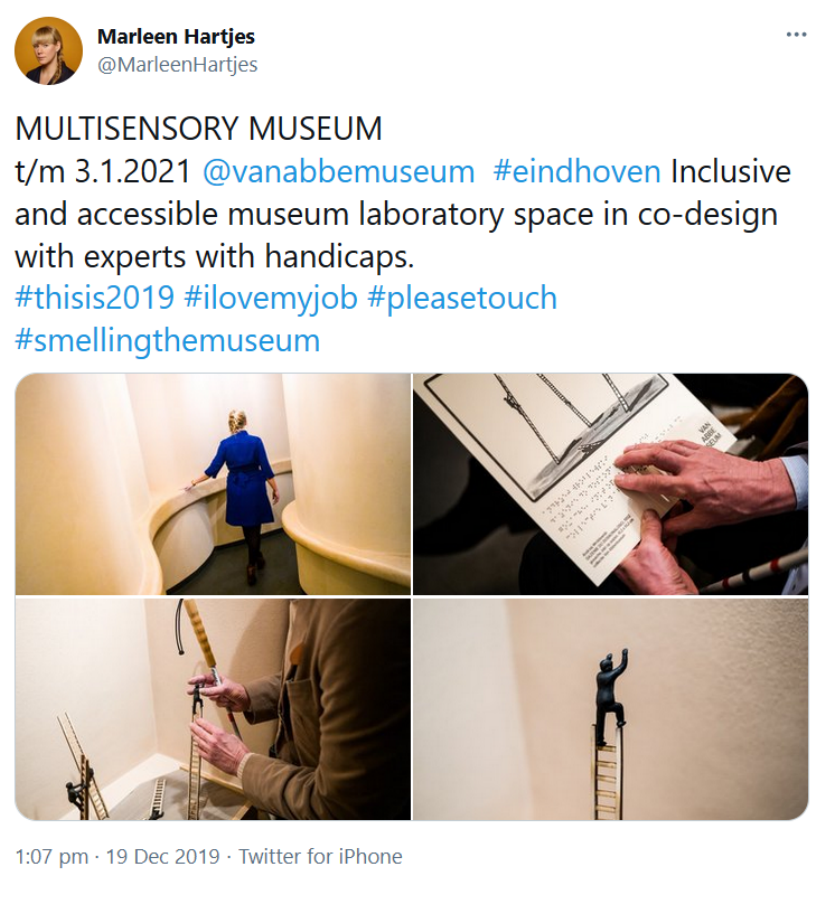
Social media communication from Marleen Hartjes, accessibility manager at the Van Abbe museum in